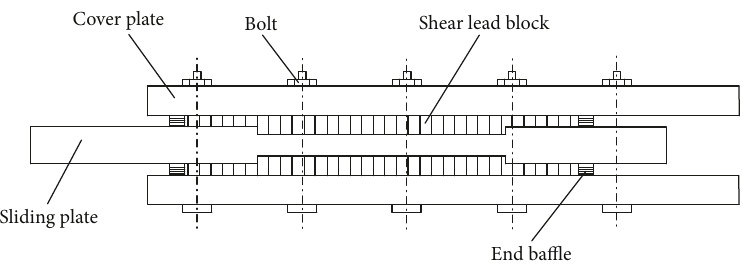
Figure 2: Mechanical structure of LSD-LS.